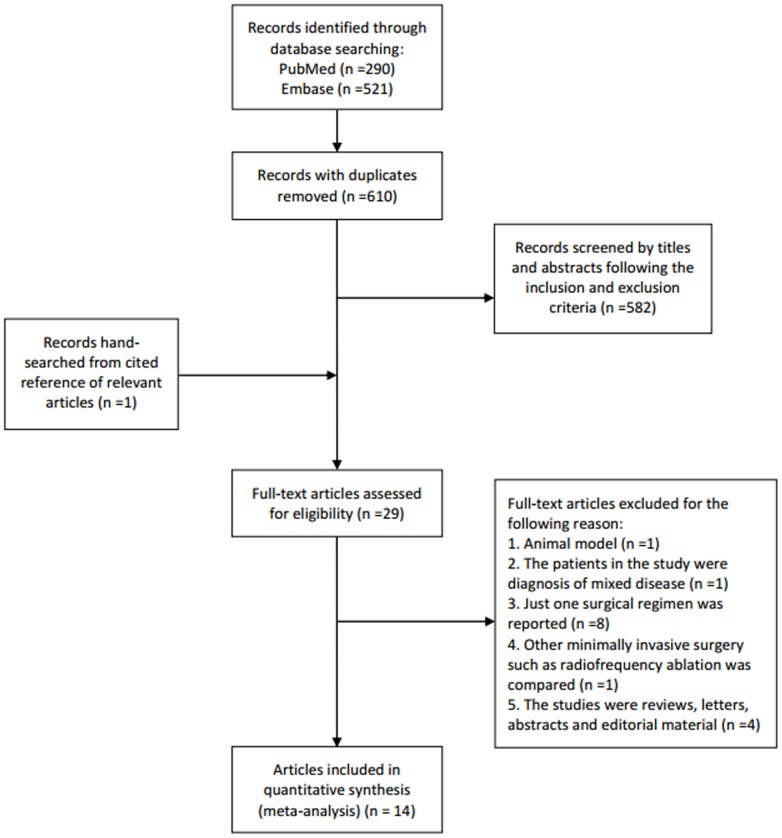
Flow diagram of meta-analysis study selection process.